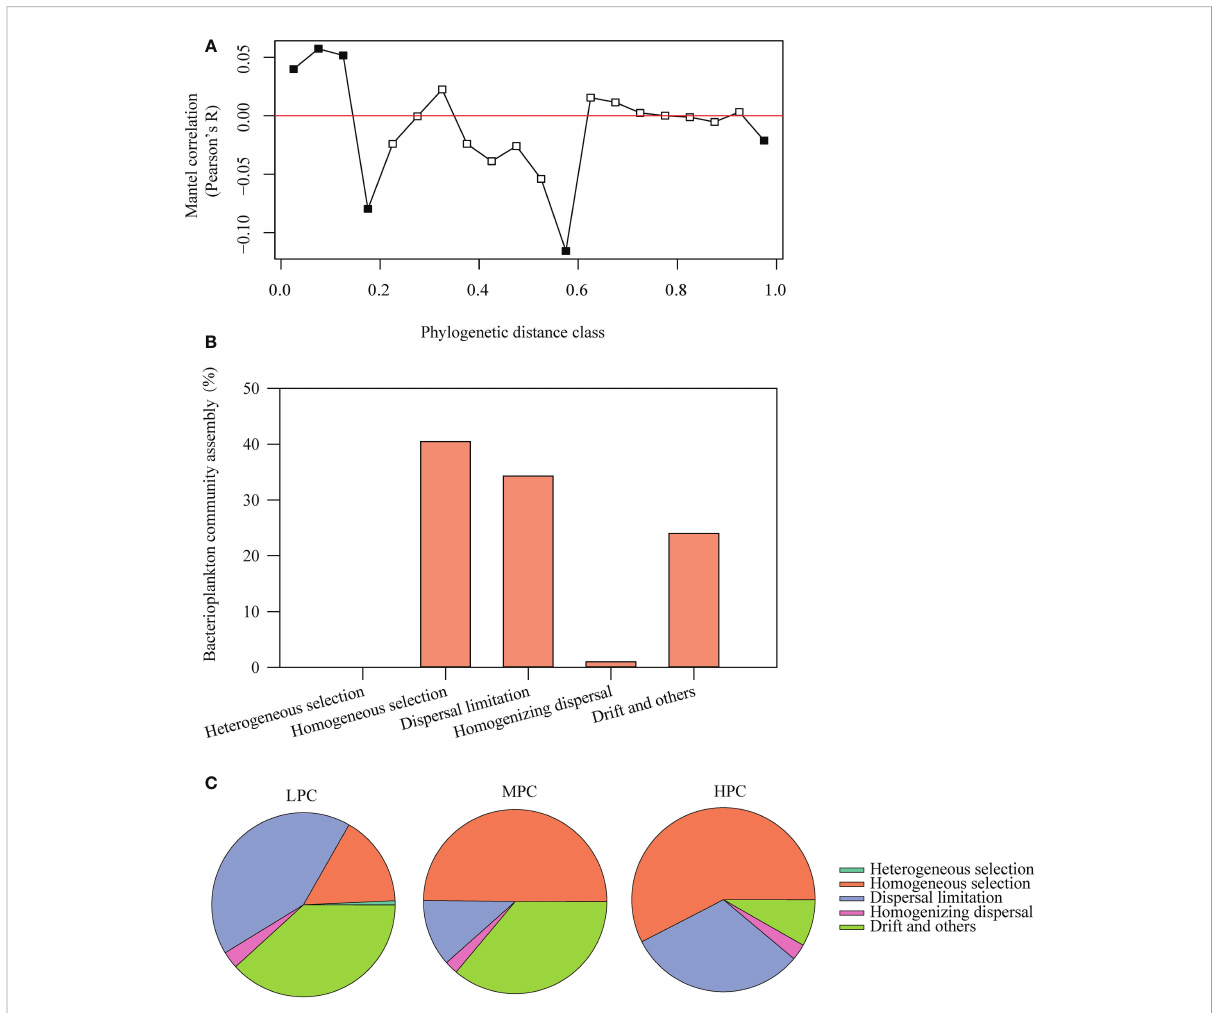
FIGURE 7 Pearson ’ s correlations from the Mantel correlogram (999 permutations) between the pairwise matrix of OTU niche distances and phylogenetic distances of bacterial community (A) , and the relative importance of bacterial community assembly processes over the whole sample set (B) and in the sample groups of different phosphate concentration (C) . The phylogenetic signal in niche associations was indicated by signi fi cant correlations ( p< 0.05, solid circles). The community assembly processes included homogeneous and variable selection, dispersal limitations, homogenizing dispersal and the drift and other fractions. LPC: the low phosphate concentration (phosphate< 0.5 mg L -1 ), MPC: the medium phosphate concentration (0.5 mg L -1 < phosphate< 1.0 mg L -1 ), and HPC: the high phosphate concentration (phosphate > 1.0 mg L -1